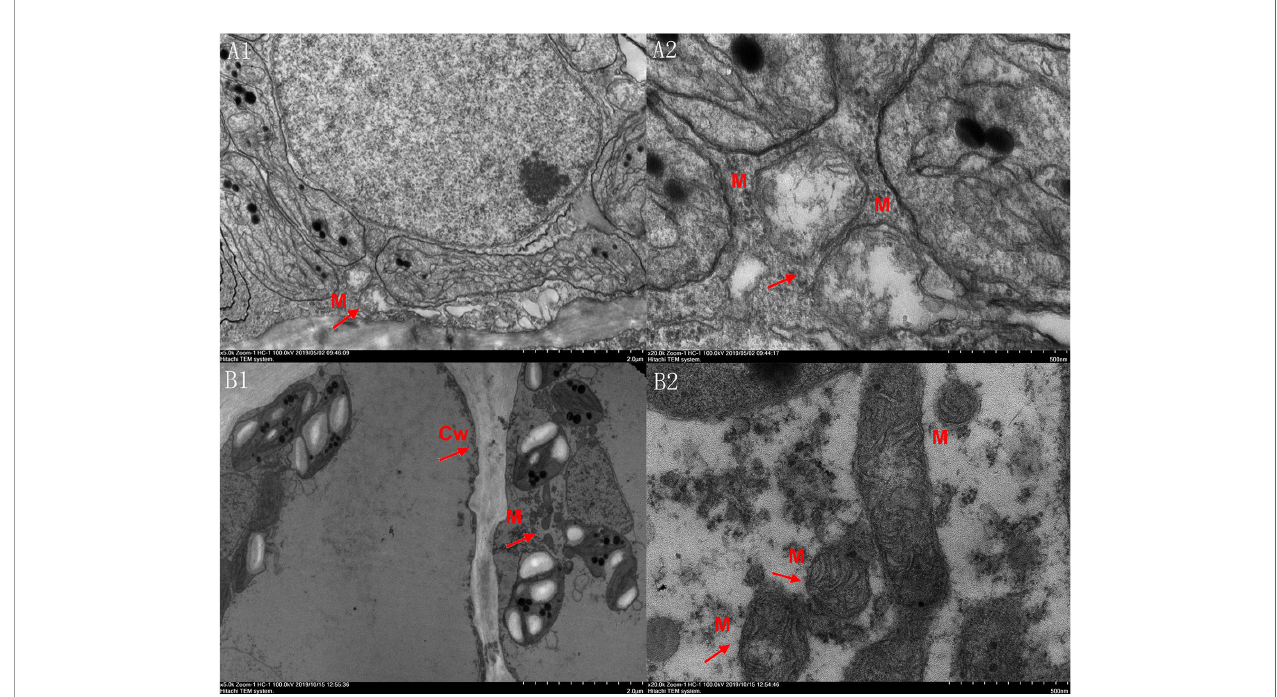
FIGURE 5 | Ultrastructure in refrigerated but untreated (A1, A2) and refrigerated with CaCl 2 -treated (B1, B2) samples with the same maturity in different magni fi cation. M, mitochondria; Cw, cell wall; Magni fi cation power: A1, B1. ×5000; A2, B2. ×20,000.